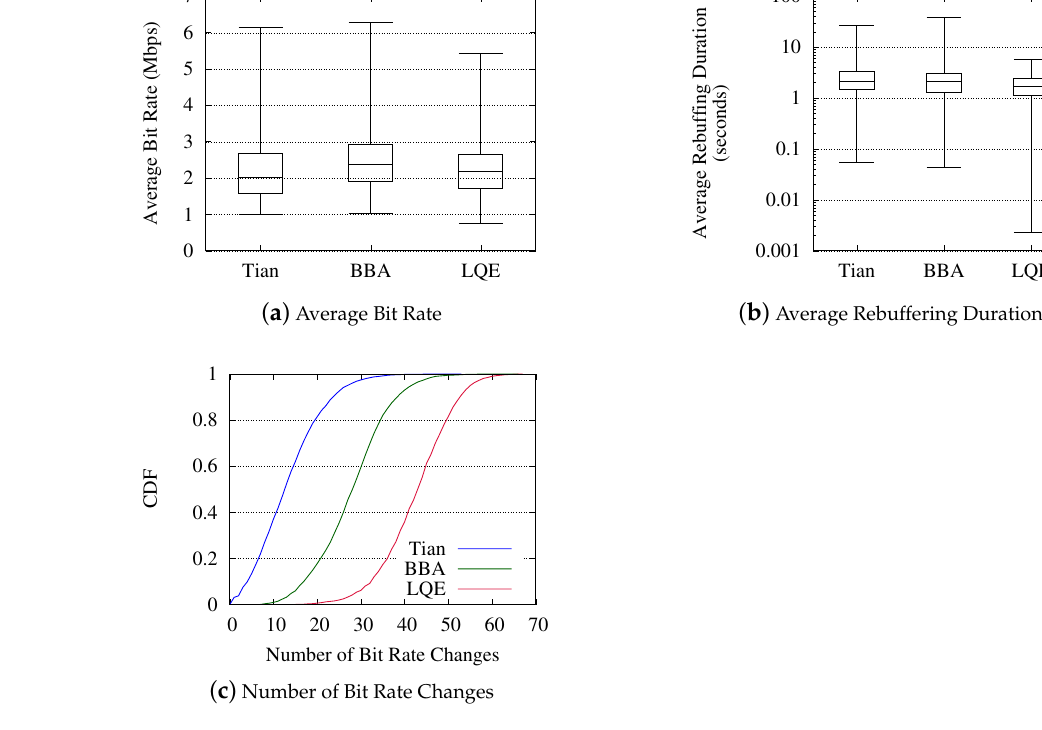
Figure 6. Comparison of